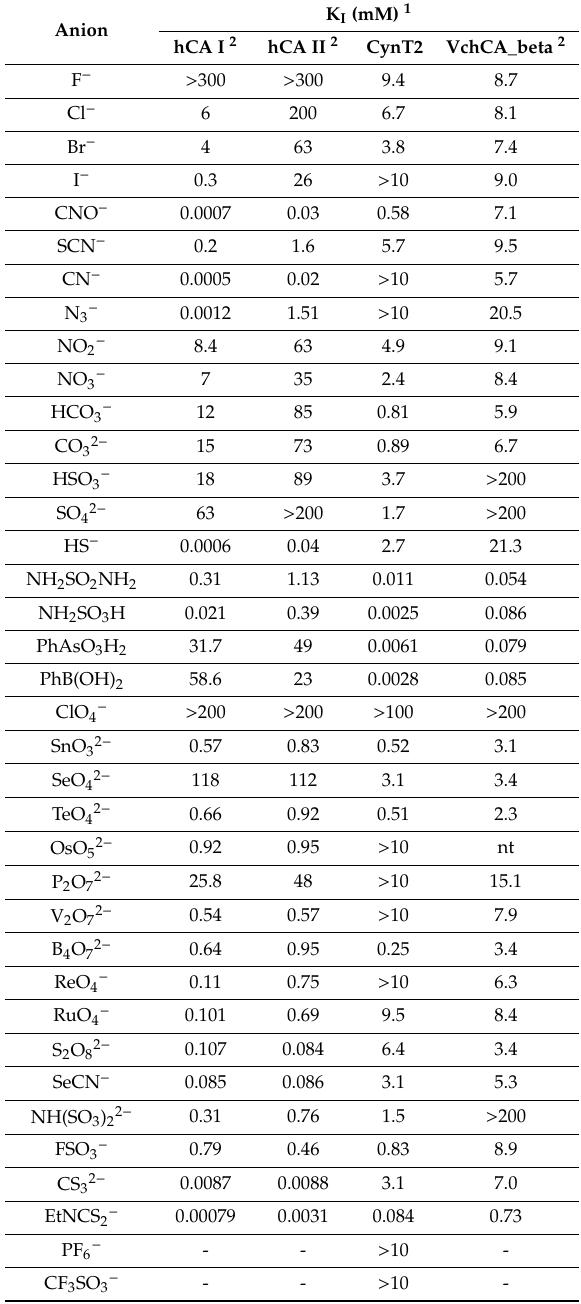
Table 3. Anions inhibition constants for the human α -CAs isoforms I and II, CynT2 ( E. coli β -CA) and the β -CA (VchCA_beta) identified in the genome of V. cholerae . The analysis was carried out by a stopped-flow assay